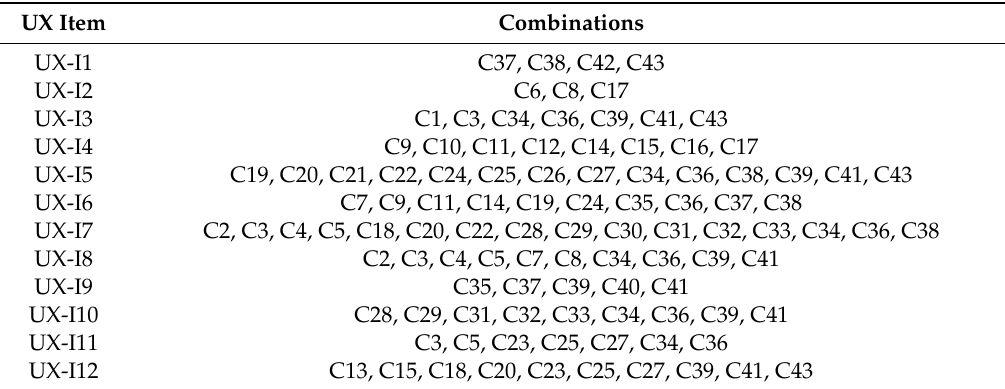
Table 3. Relationships between UX items and